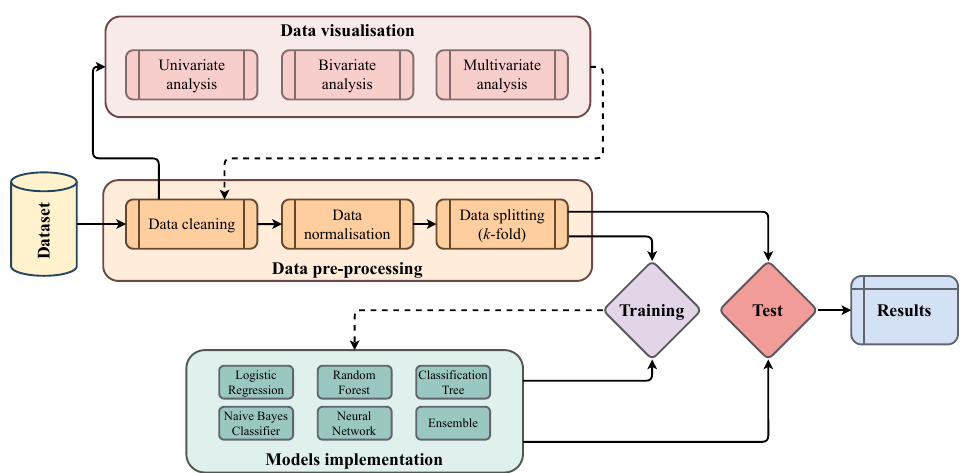
Figure 1. Image representing the experimental workflow implemented in our paper.